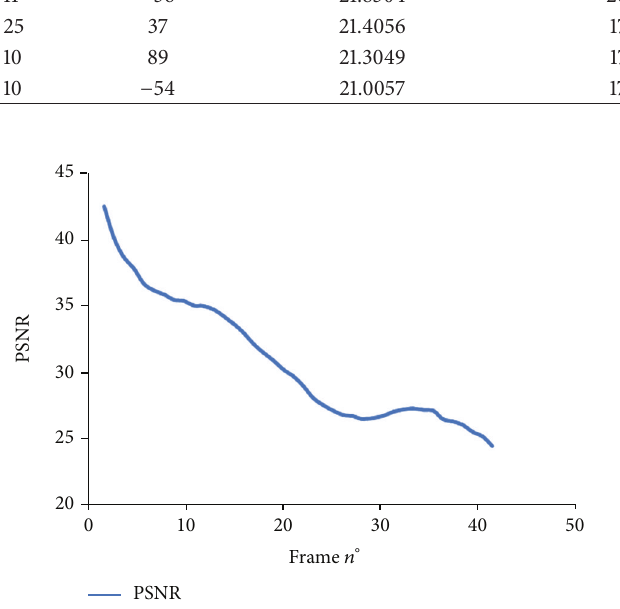
Figure 12: Trend of PSNR ( 𝜌 = 0.006944 ) with respect to frame number for the video Mom-Daughter.